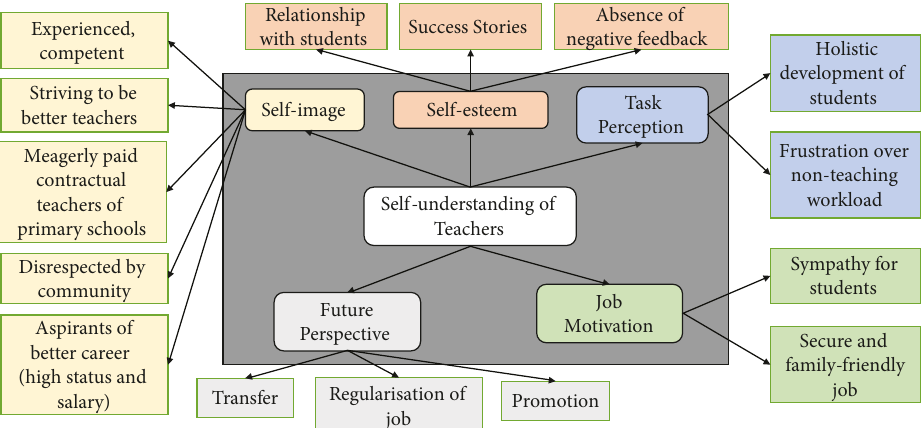
Figure 1: Self-understanding of early career primary school teachers in